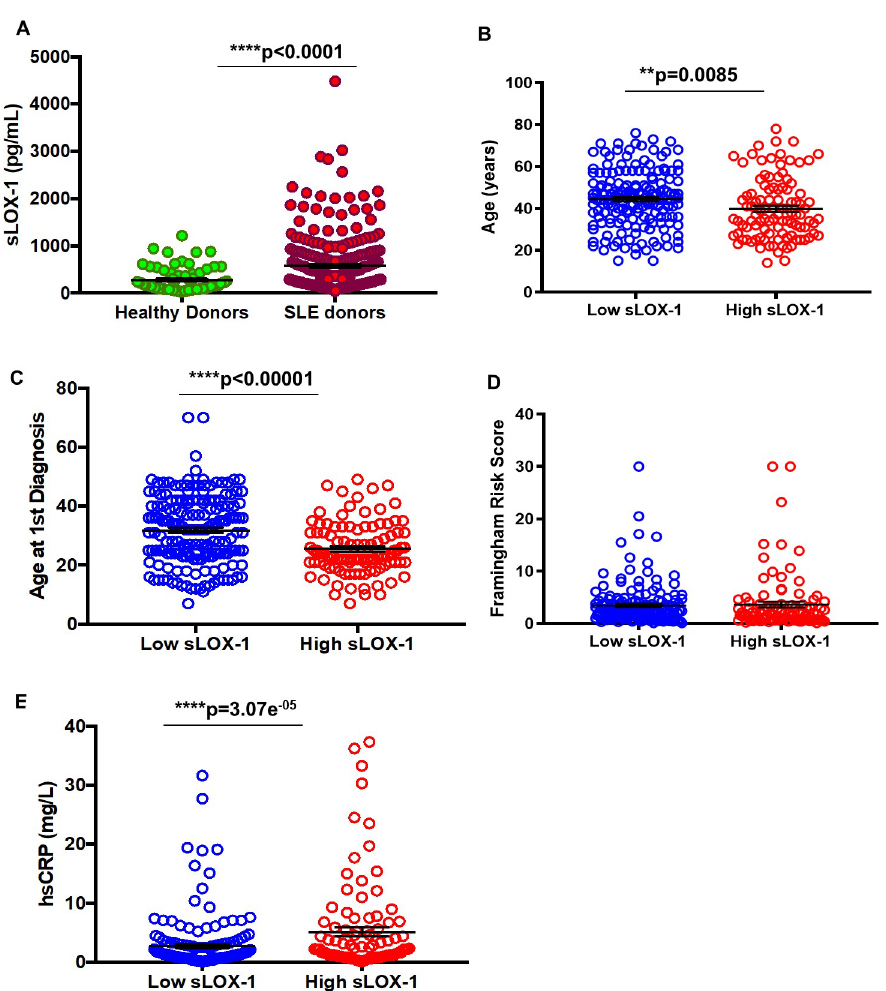
Fig 1. Measurement of sLOX-1 levels in healthy versus SLE donors and relationships between sLOX-1 and age, Framingham risk scores (FRS) and hsCRP. (A) Serum from healthy (n = 72; sLOX-1 pg/mL mean = 274.9 ± 30.34 SEM) and SLE (n = 273; sLOX-1 pg/mL mean = 580.9 ± 36.1) individuals were measured for levels of sLOX-1 using an MSD-based ELISA assay. Bars represent mean ± standard error (SEM). (B) Age of patients with low sLOX-1 levels < 532 pg/mL (44.53 ± 1.035 years, n = 171) and high sLOX-1 levels > 532 pg/mL (39.82 ± 1.442 years, n = 102) were analyzed. (C) Age of first SLE diagnosis in patients with low sLOX-1 (31.83 ± 0.9143, n = 170) versus high sLOX-1 (25.55 ± 0.8747, n = 103) levels. (D) 10-year FRS were calculated based on patients’ sex, age, systolic blood pressure (SBP), use of antihypertensive treatment, smoking and diabetes, cholesterol and LDL cholesterol levels. (E) Clinical hsCRP (mg/dL) measurements were used to analyze levels between low and high sLOX-1 patients. � p < 0.05, �� p < 0.01, ��� p < 0.001 and ���� p < 0.0001. were analyzed in the two sLOX-1 groups. Fewer patients were seropositive for ENA, which measures antibodies to saline-extracted antigens, anti-RNP, anti-SmRNP, anti-Ro, anti-La, anti-Sm, Scl-70, anti-Jo-1, in the high sLOX-1 group versus low sLOX-1 group, and there was a similar trend for ANA and anti-dsDNA. High sLOX-1 patients also had lower prevalence of hypocomplementemia (Table 1) and higher C3 and C4 levels in comparison to patients with low sLOX-1 (Fig 2A and 2B and Table 1). Complement levels also show moderate positive association with sLOX-1 as measured by correlation r = +0.36 (p = 1.30e -09 ) (Table 1). Plate- s lets and white blood cell (WBC) counts were increased in the high sLOX-1 group (Fig 2C and 2D and Table 1). Erythrocyte sedimentation rate (ESR) which is an indicator of inflammation